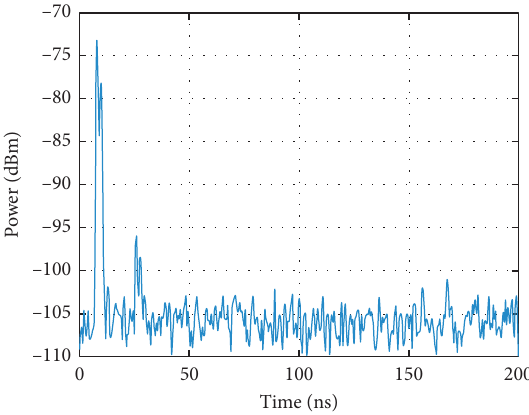
Figure 3: Omnidirectional PDP at 28 GHz in step 5 of the stairs.